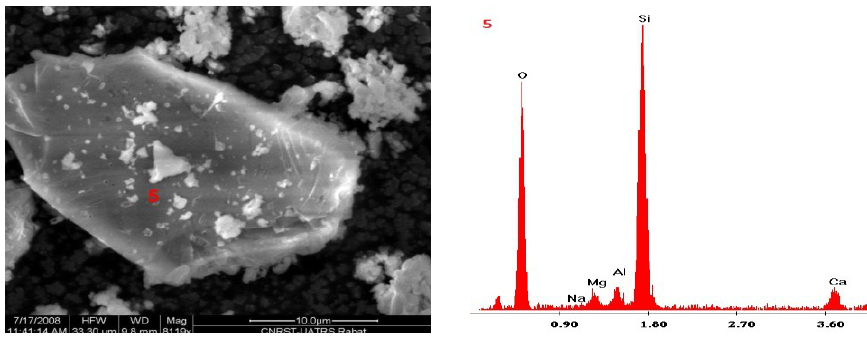
Figure 8. SEM image and EDX analysis of Quartz detected in OSA.